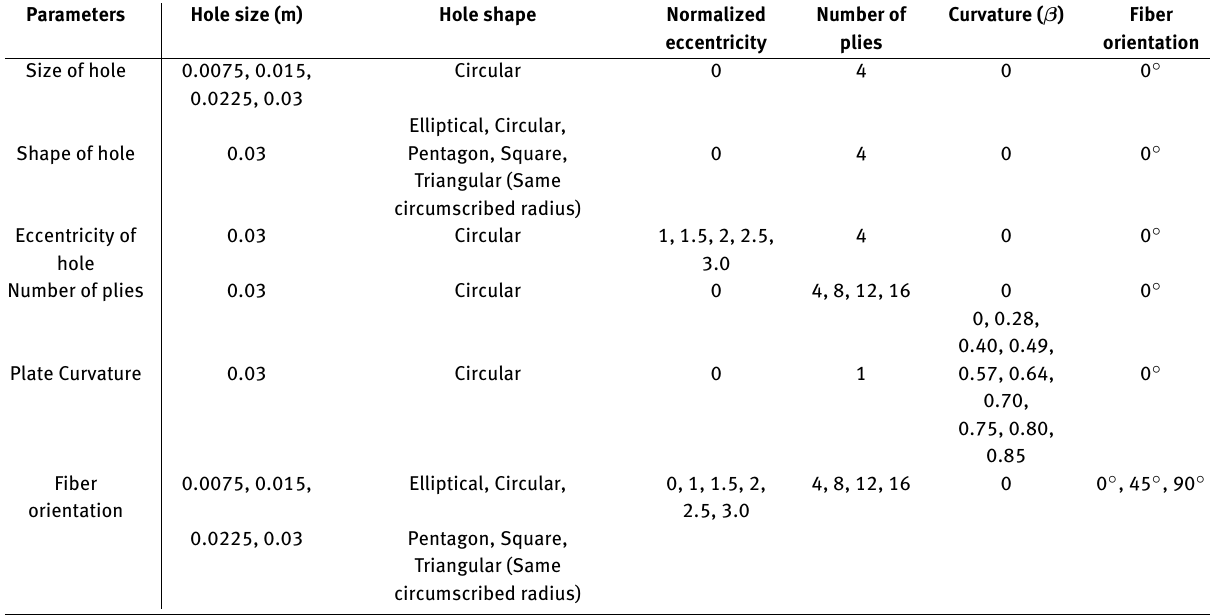
Table 2: Geometric configurations considered for parametric study Parameters